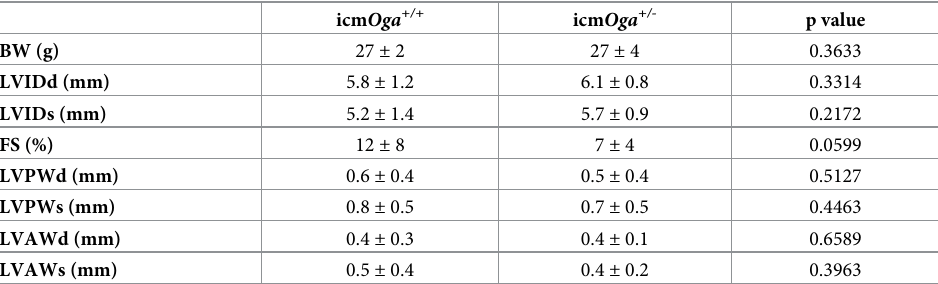
Table 1. Echocardiography data at 1 wk